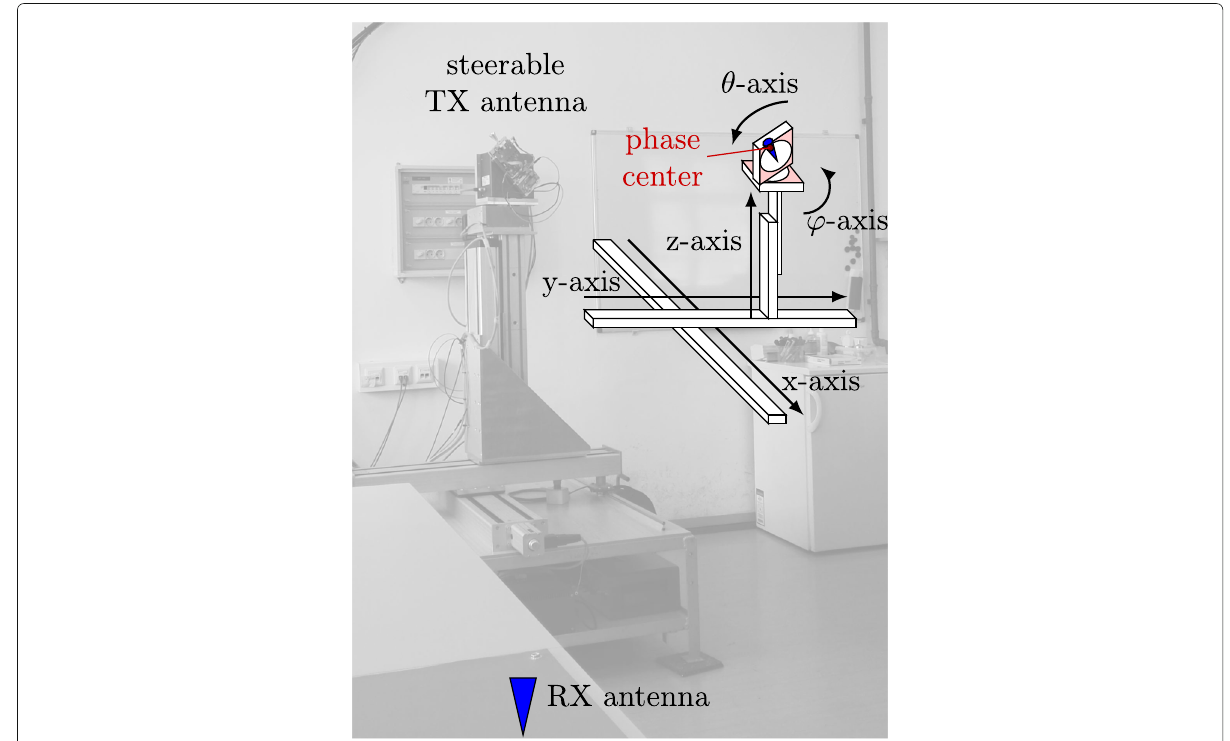
Fig. 5 Photograph of the improved mechanical set-up for MC2 from the receiver point of view. Our mechanical set-up consists now of five independent axes to fully compensate all offsets introduced by rotation. A schematic sketch is superimposed. All five axes are necessary to rotate the horn antenna around the phase centre at a fixed ( x , y , z ) coordinate. Notice that TX and RX switch roles as compared to Fig. 4